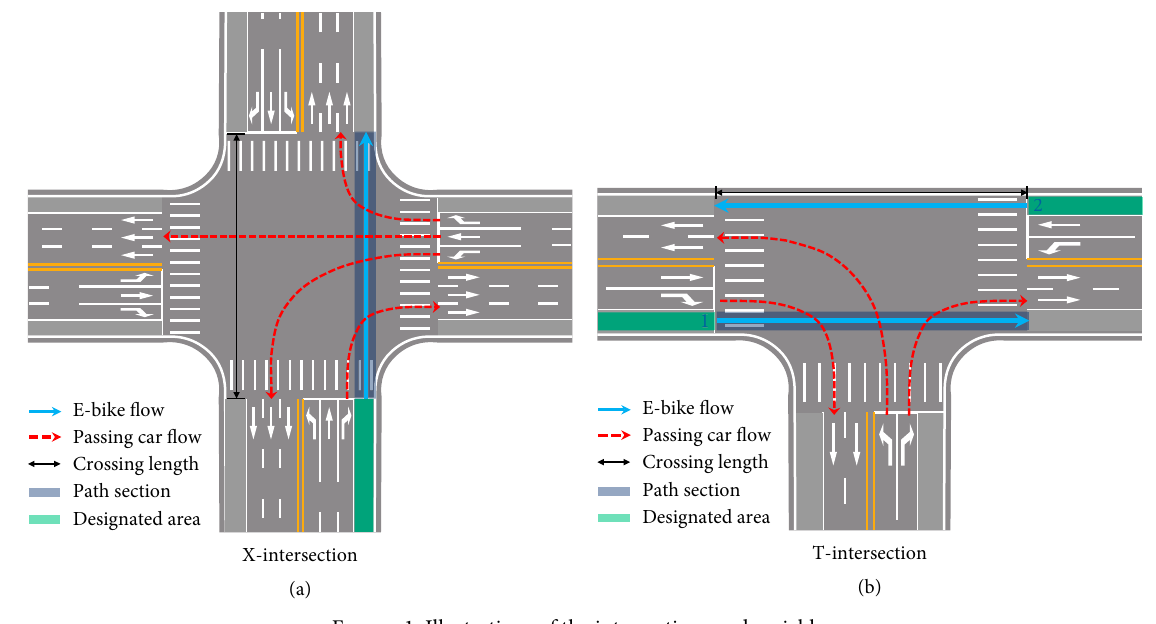
Figure 1: Illustrations of the intersections and